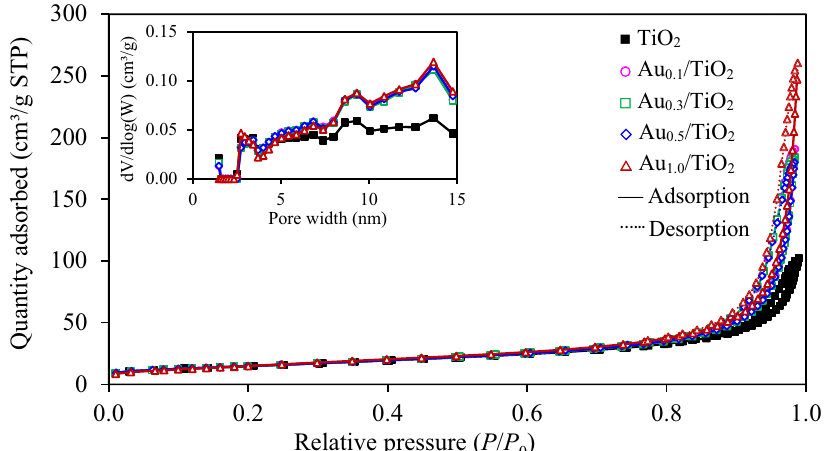
Figure 5. Representative N 2 adsorption/desorption isotherms of commercial TiO 2 and Au x /TiO 2 NPs synthesized by photodeposition at different gold loadings in the range of 0.1–1.0 wt%.